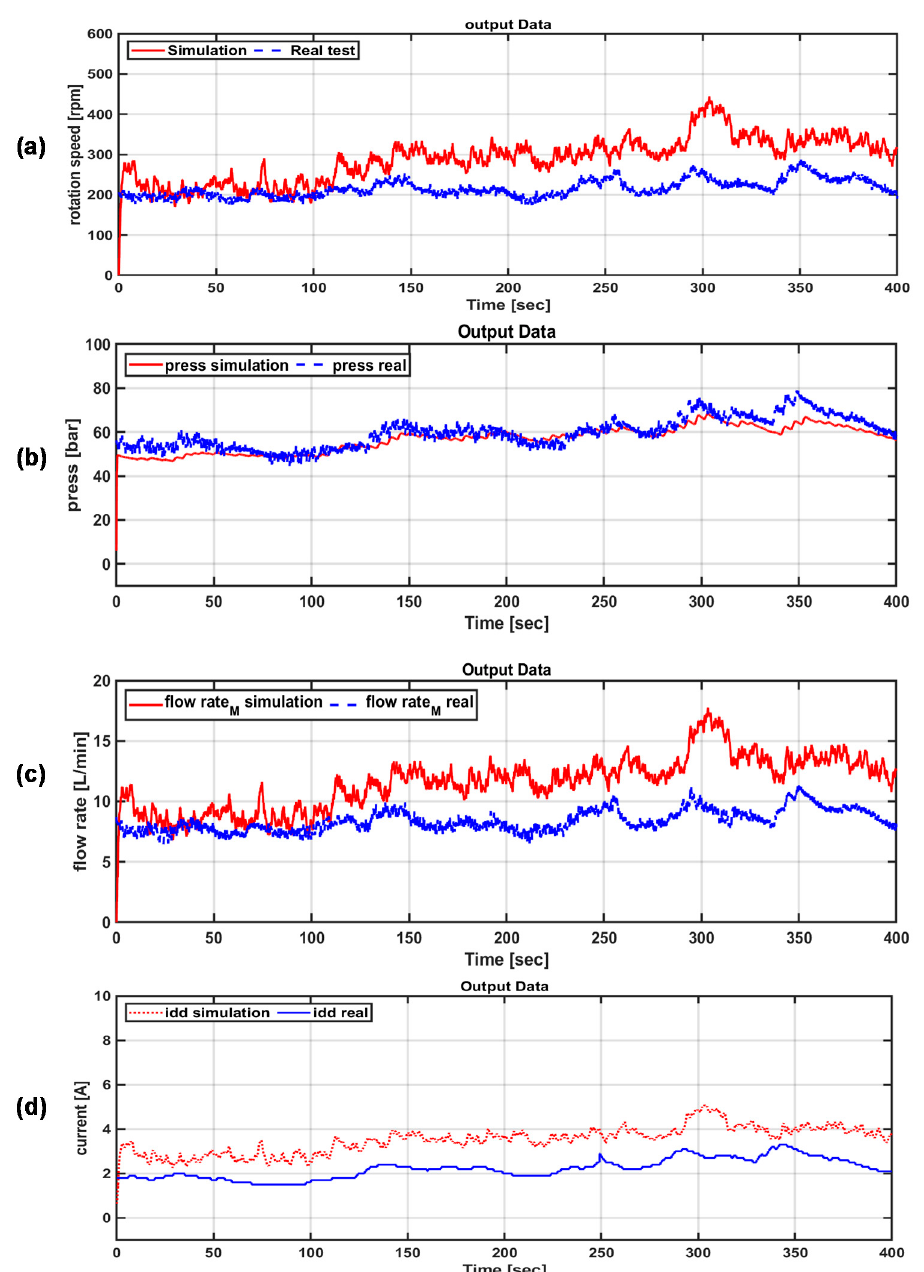
Figure 30. Comparison of the PTO system characteristics according to the actual sea test and optimal torque control simulation. ( a ) rotation speed; ( b ) mechanical pressure; ( c ) flow rate; ( d ) electrical load current.